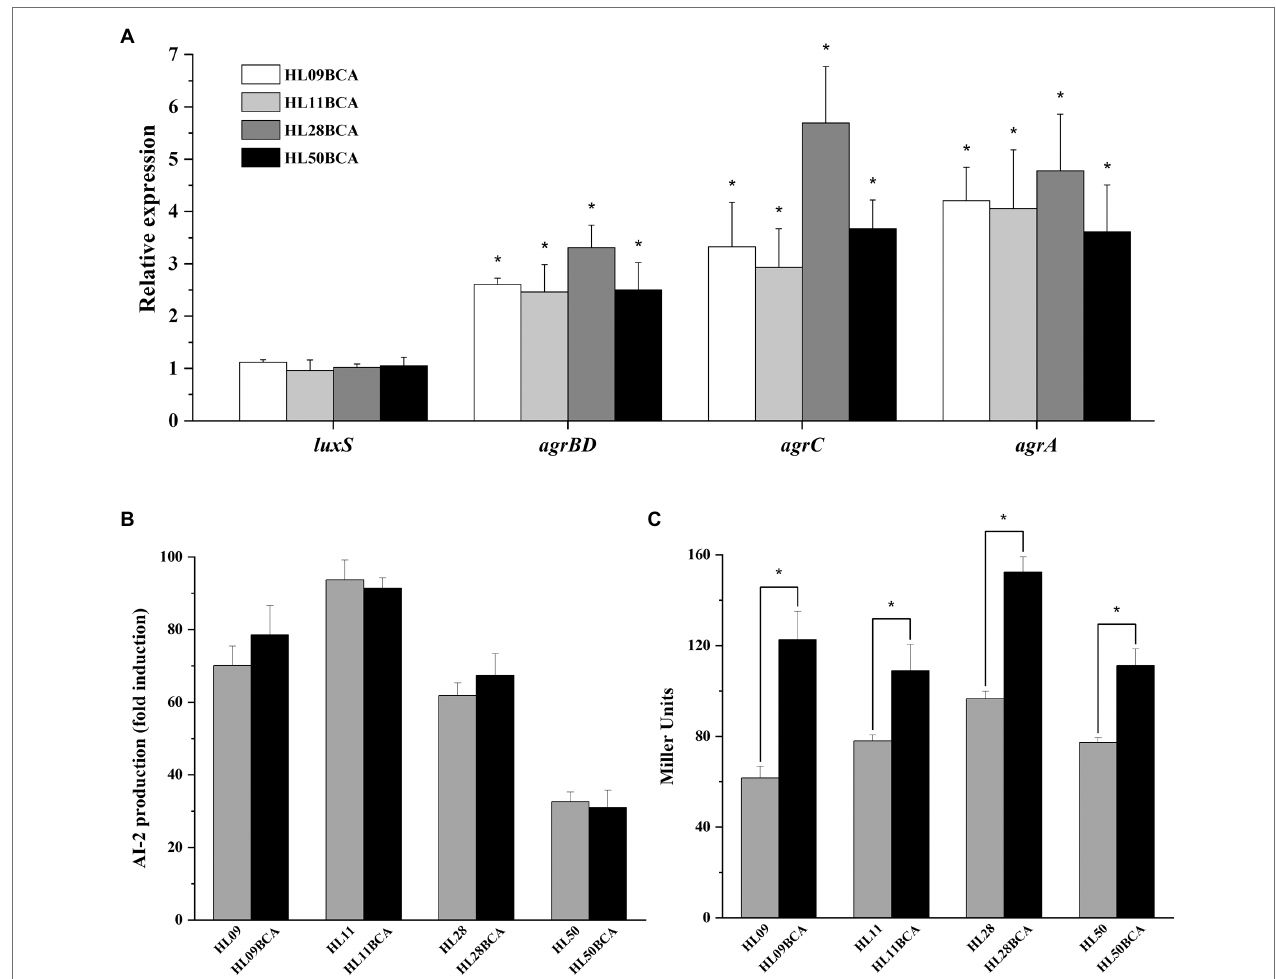
FIGURE 1 | Effect of BC adaptation on (A) the expression levels of luxS and agr , (B) AI-2 production, and (C) the agr promoter (P 2 ) activity. Relative expression levels of luxS and agr are presented as fold changes of the gene tested in BC adapted strain compared to that in its wild-type strain. Error bars represent the standard deviation of triplicate experiments ( n = 3). The asterisk indicates a value statistically different from that of the wild-type strain, with p <